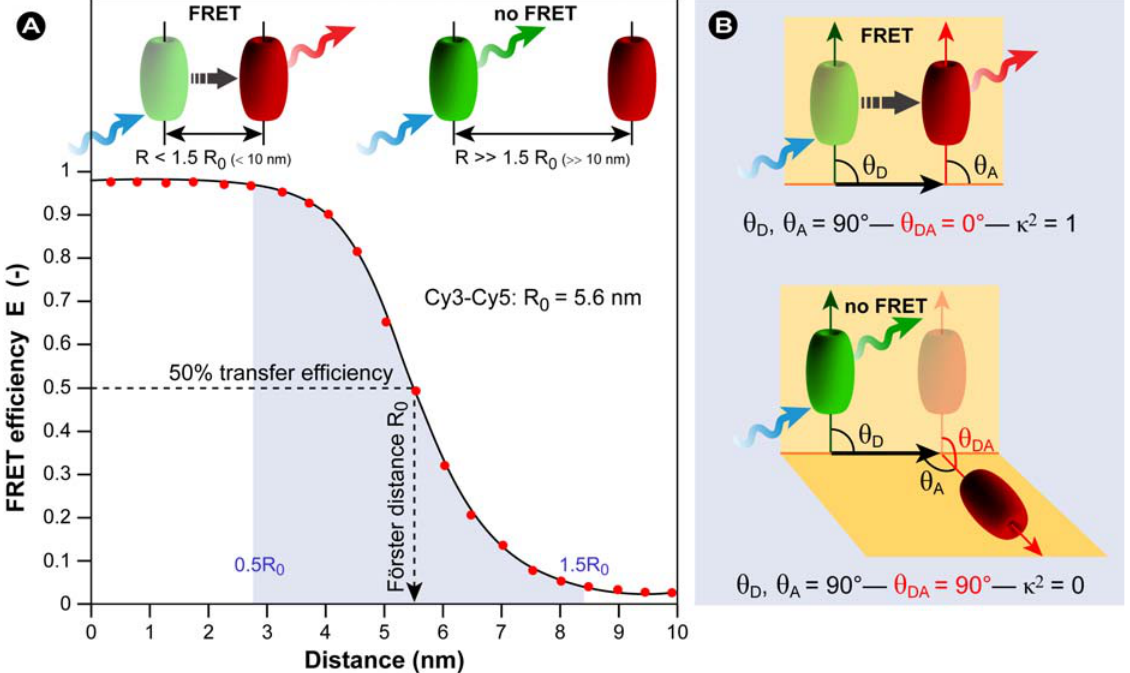
Figure 18. Schematic representation of FRET as a photophysical process. FRET depends on the close proximity of a donor and acceptor pair of fluorescent molecules in which the emission spectrum of the donor overlaps the excitation spectrum of the acceptor. Because these molecules must be in proximity of less than 10 nm for FRET to occur, the spatial resolution of the microscope is significantly improved. If only the donor fluorochrome is excited and the acceptor molecule is too distant from it, only donor fluorescence will be detected. However, when the acceptor is closer to the excited donor, energy can be transferred non-radiatively from donor to acceptor (FRET). The intensity of donor emission decreases, while an acceptor emission can be distinctly